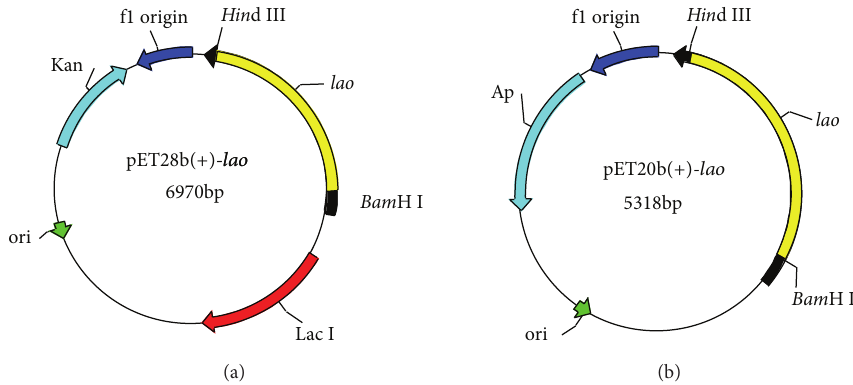
Figure 5: Maps of the recombinant plasmids containing lao -gene, pET28b(+)- lao (a), and pET20b(+)- lao (b). The LAAO-encoding gene was cloned between Bam H I and Hin d III restriction